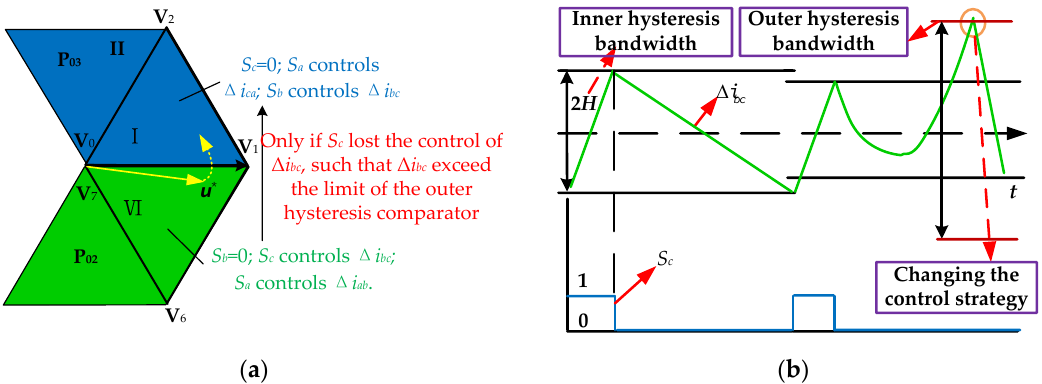
Figure 4. The limit exceeding of current error resulted by the transition of u *. ( a ) u * moves from region VI to region I; ( b ) current error exceeds the limit.